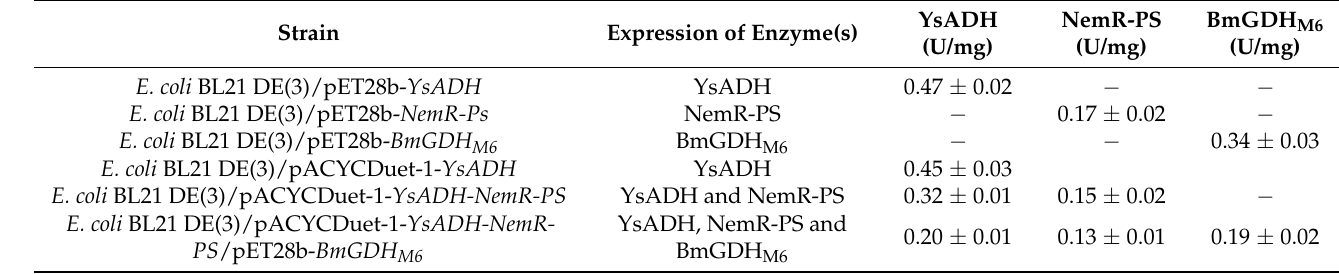
Table 2. The activities of YsADH, NemR-PS, and BmGDH M6 in cell-free extracts 1